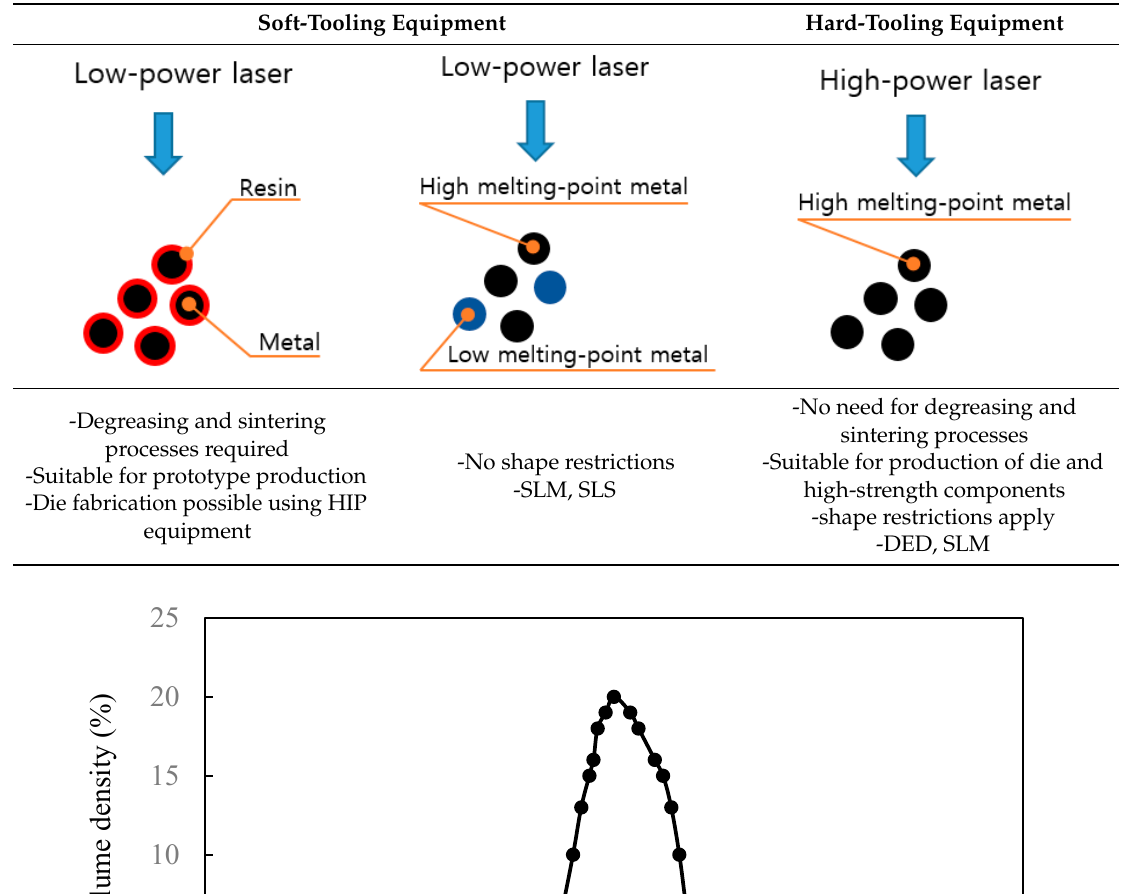
Table 3. Characteristics of soft- and hard-tooling metal additive manufacturing (AM) equipment.